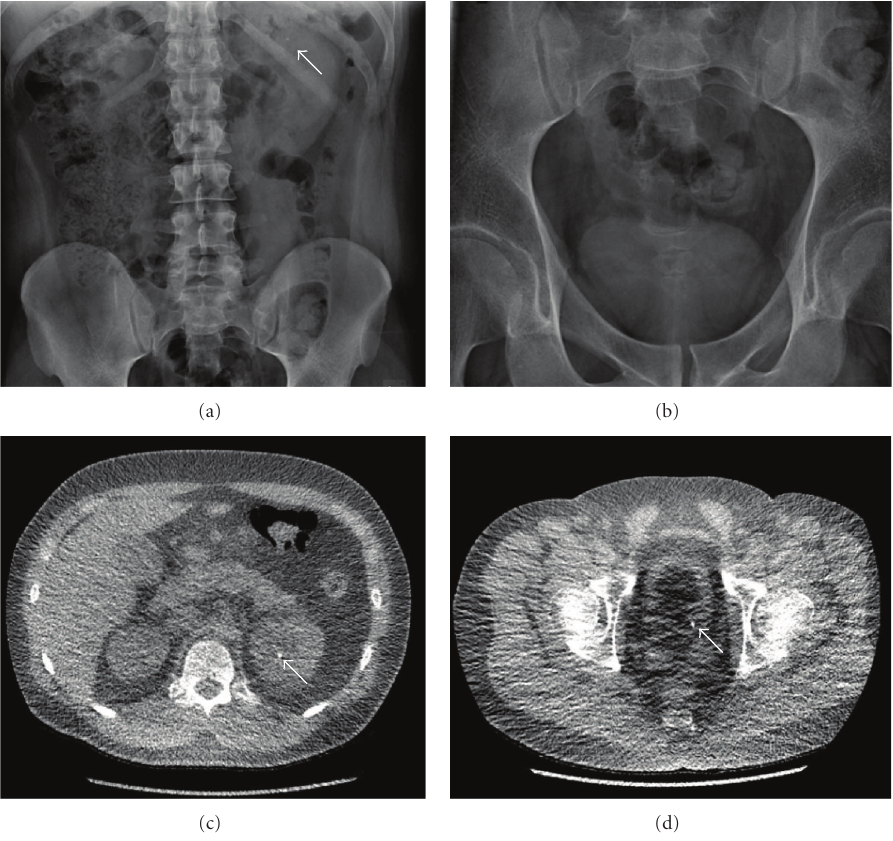
Figure 1: A 25-year-old male presenting with left flank pain. (a) Plain radiograph of the abdomen showing a possible renal calculus in the upper pole of the left kidney (estimated institutional dose ∼ 0.7 mSv). The coned pelvic radiograph (b) does not demonstrate a calculus in the pelvis. Low-dose CT KUB (e ff ective dose of 0.5 mSv) (c) and (d) clearly identifies a 5 mm calculus in the upper pole of the left kidney, as well as a 4 mm calculus, at the left ureterovesical junction. The latter was not seen on the plain